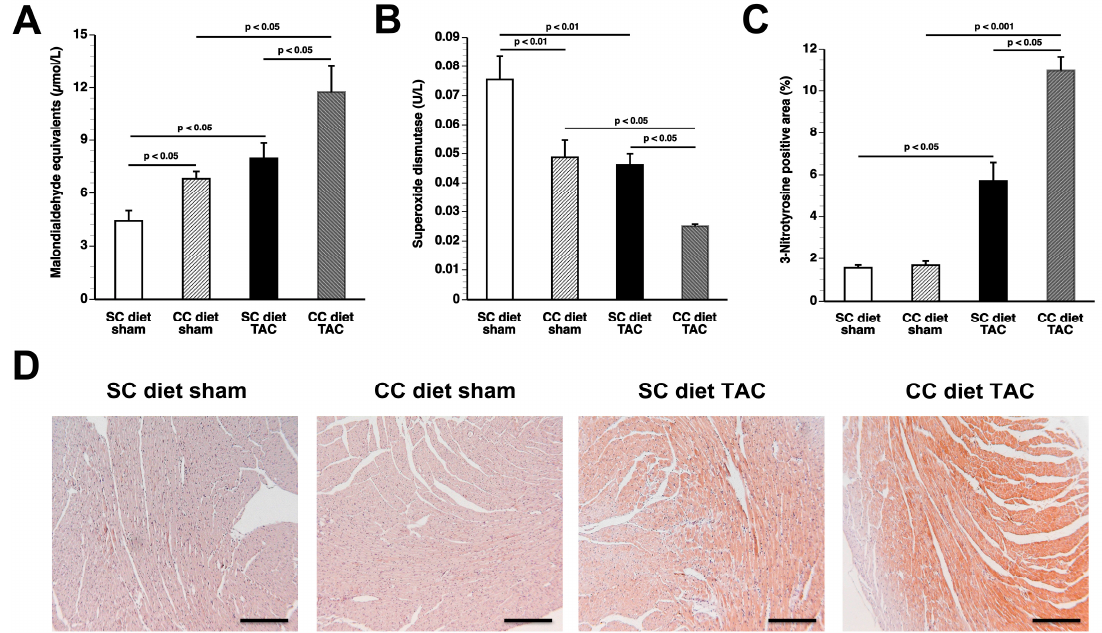
Figure 9. Quantification of oxidative stress in sham mice and in TAC mice at Day 56 after operation: sham mice and TAC mice are indicated by open bars and closed bars, respectively: ( A ) Plasma TBARS expressed as plasma malondialdehyde equivalents; ( B ) superoxide dismutase activity; ( C ) percentage of 3-nitrotyrosine-positive myocardial area; and ( D ) representative photomicrographs showing myocardial sections stained for 3-nitrotyrosine. All data represent means ± SEM ( n = 16). Scale bar represents 100 µm.